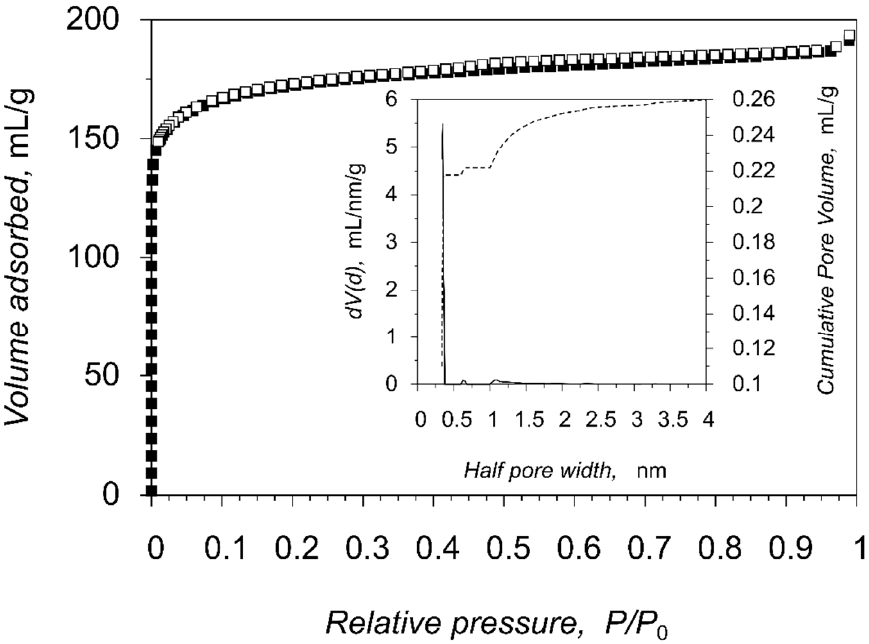
Figure 6. Nitrogen adsorption (filled squares) and desorption (open squares) isotherms at 77 K for compound 1 . The inset shows the pore size distribution.